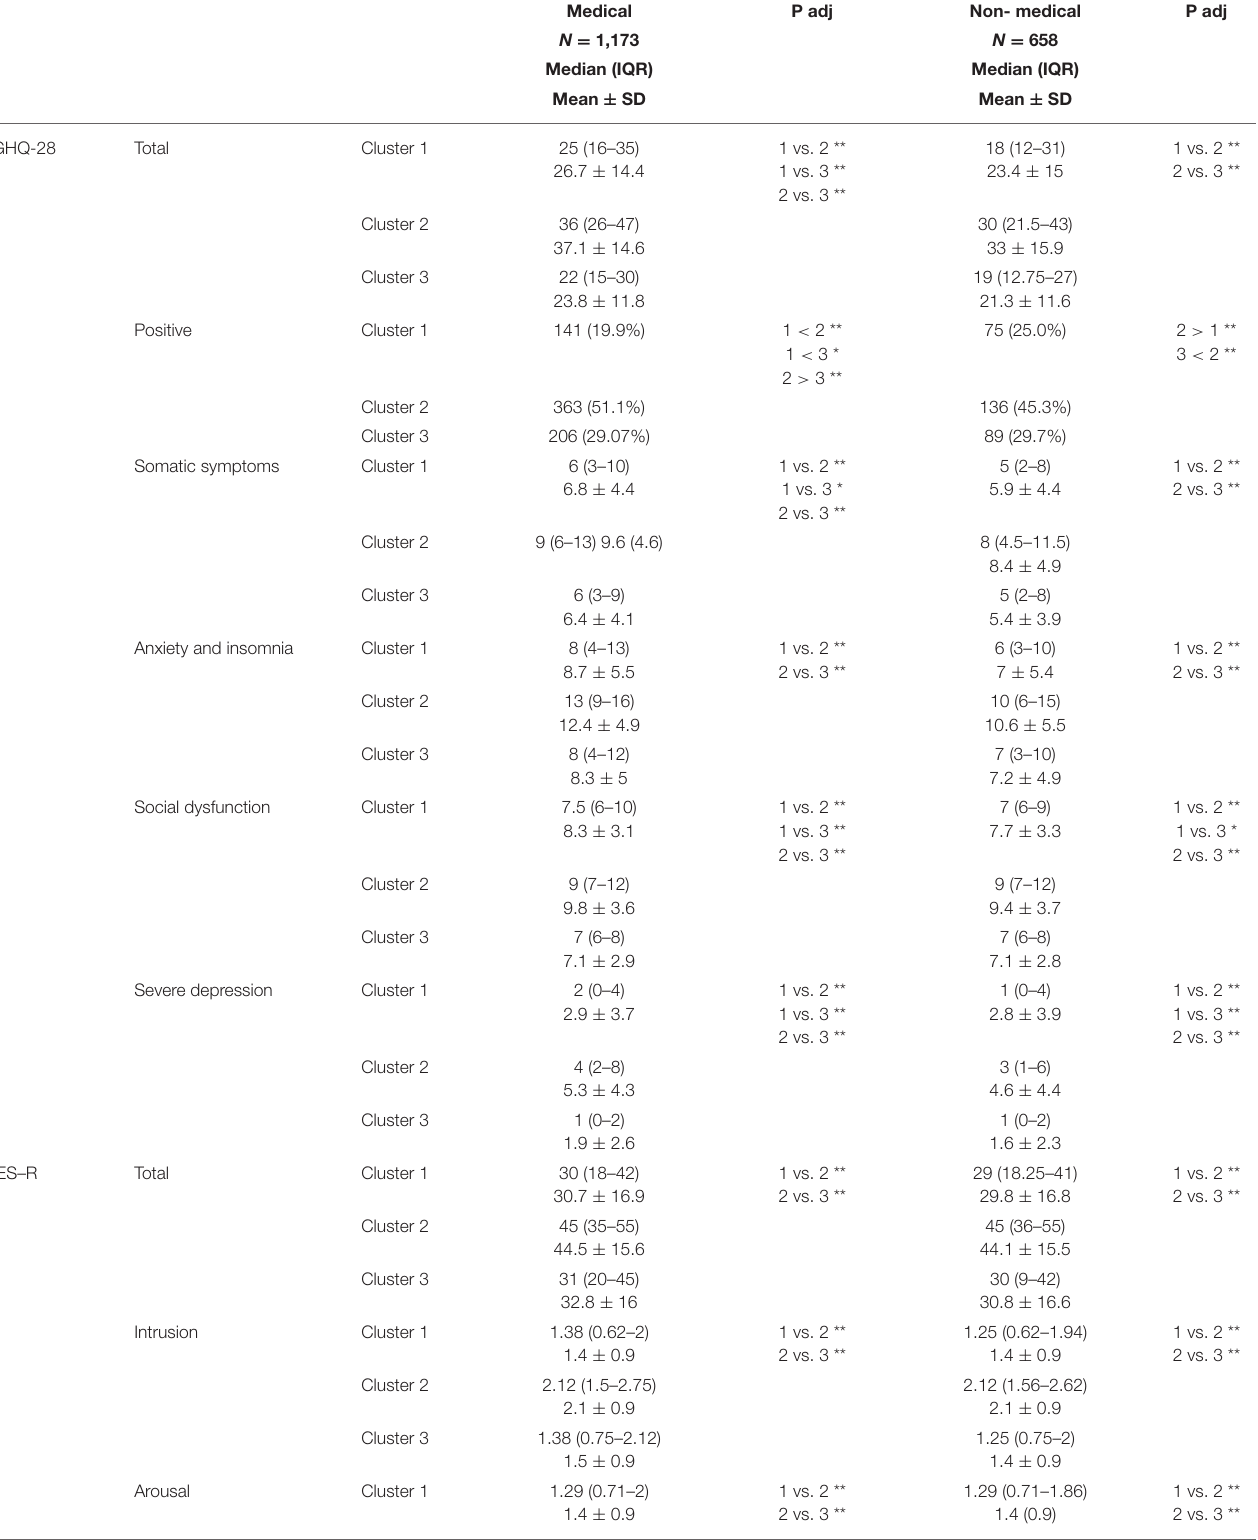
TABLE 3 | Comparison of GHQ-28 and IES-R outcomes regarding particular cluster of coping in medical and non-medical